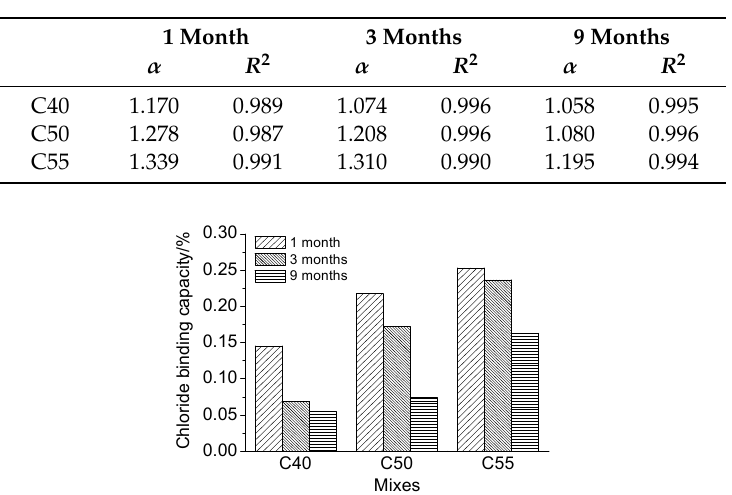
Figure 13. Chloride binding isotherms of C40, C50, and C55 exposed to the tidal zone after different times. ( a ) 1 month. ( b ) 3 months. ( c ) 9 months. Table 5. Slope ( α ) and correlated coefficient ( R 2 ) of chloride binding isotherms.